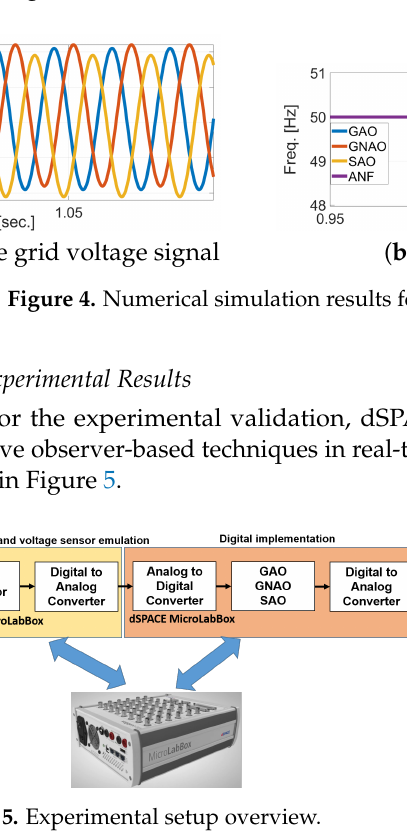
Figure 3. Numerical simulation results for Test-III.